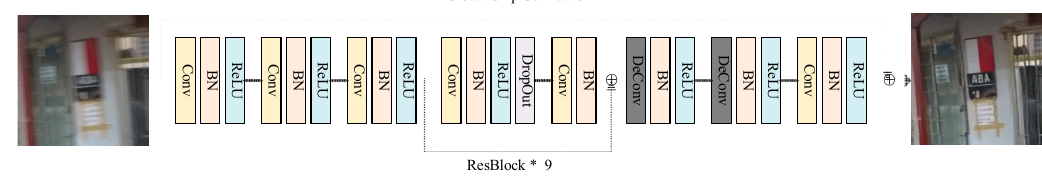
Figure 2. Generator network. Figure 2. Generator